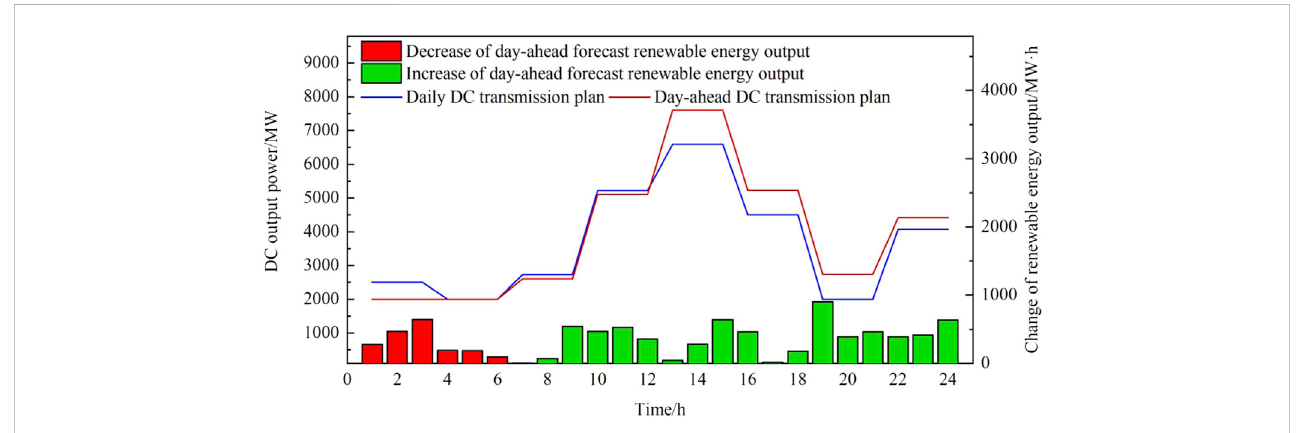
FIGURE 3 Day-ahead optimization results of January